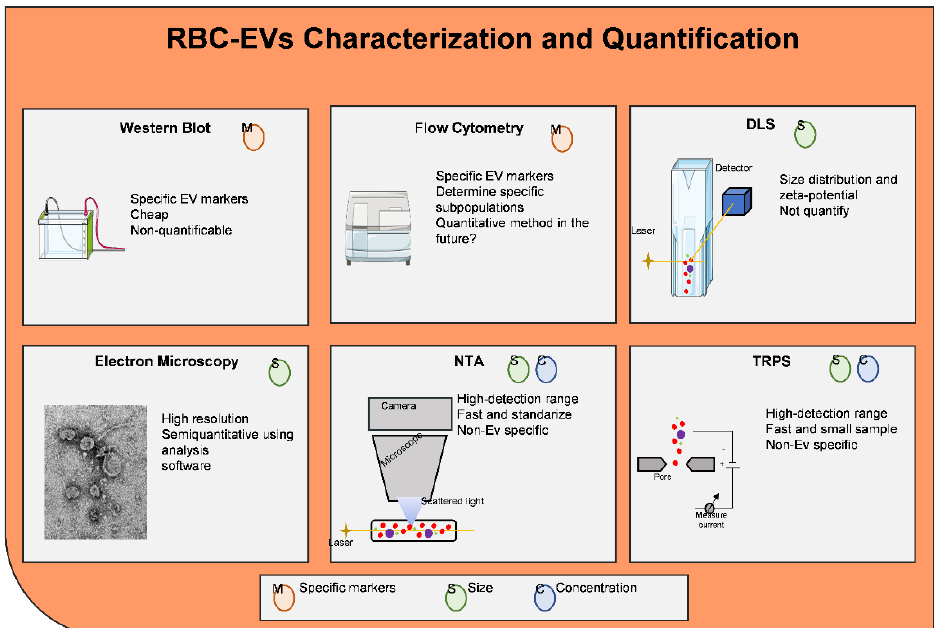
Figure 4. Characterization and quantification of EVs. RBC-EVs can be characterization by western blots, flow cytometry, and electron microscopy. Transmission electron microscopy (TEM), scanning EM (SEM), and cryogenic TEM are largely applied to determine EV features (diameters and morphology). RBC-EV size distribution and polydispersity in a sample can be also analyzed by dynamic light scattering (DLS), which detects the diffusion coefficient of the scattering EVs. Nanoparticle tracking analysis (NTA) allows for the detection of both EV dimensions and concentrations, through the analysis of the EV Brownian motion and the measurement of scattered light (Sc-NTA) or emitted fluorescence (Fl-NTA). Tunable resistive pulse sensing (TRPS) is only measuring particle concentration. Spectradyne’s nCS1Tcan delivers accurate measurements of exosome/vesicle size and concentration in minutes, using microfluidic resistive pulse sensing (MRPS). Exosomes in the circulation carry biomarkers originated from the donor cells, and exosomes contain various markers which indicate their origins, e.g., CD235a (GPA)